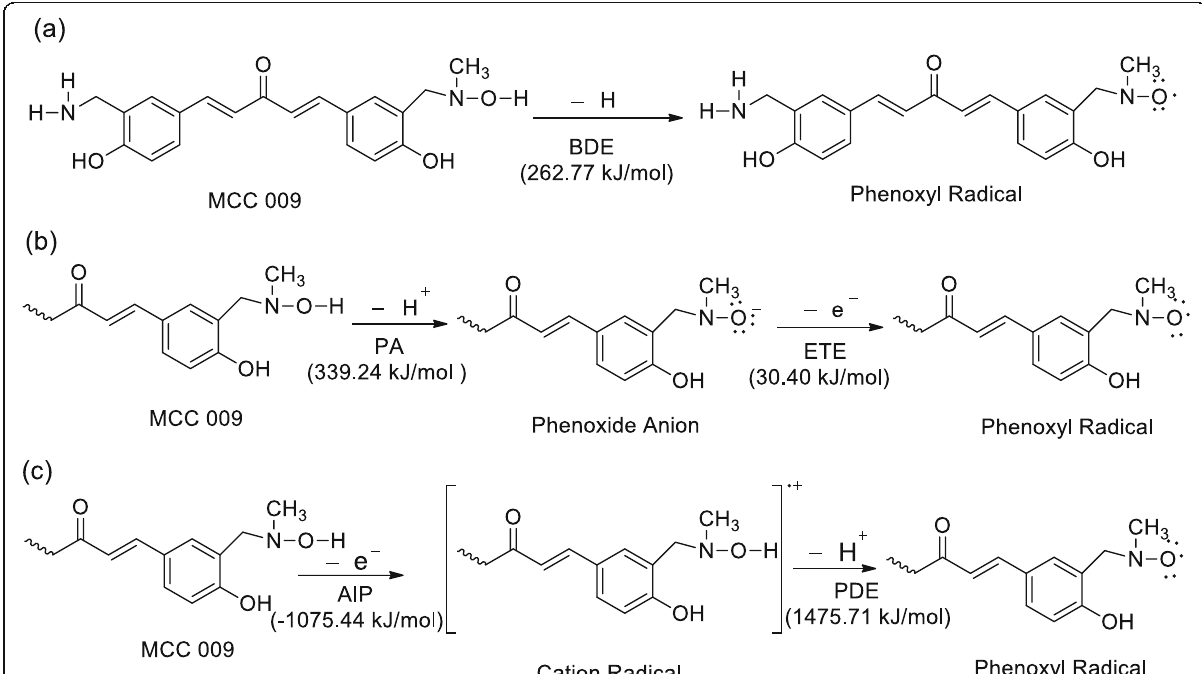
Δ G r BDE Gas Water Gas Water Gas Water Gas Water Gas − 8.99 −